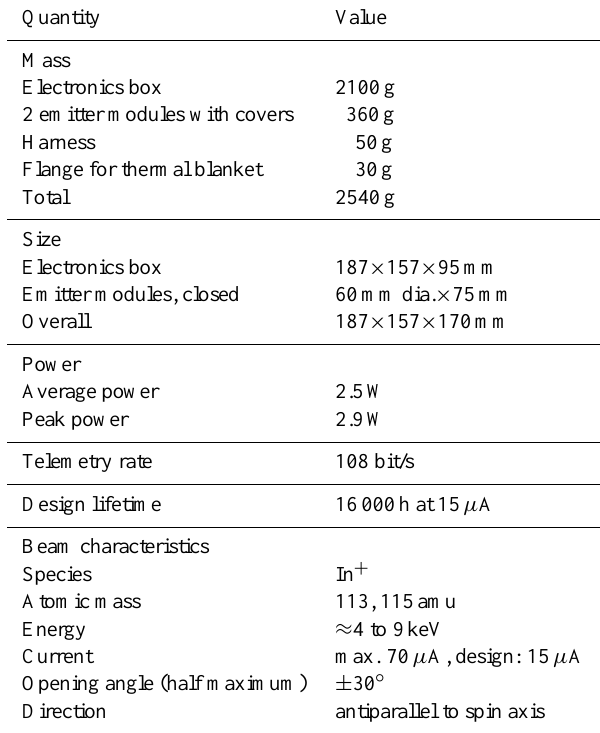
Table 1. Instrument data